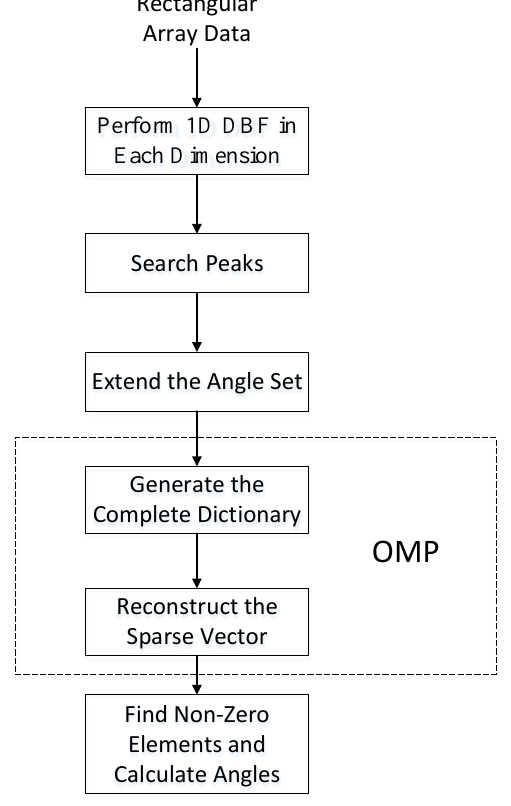
Figure 2. Flow chart of our proposed